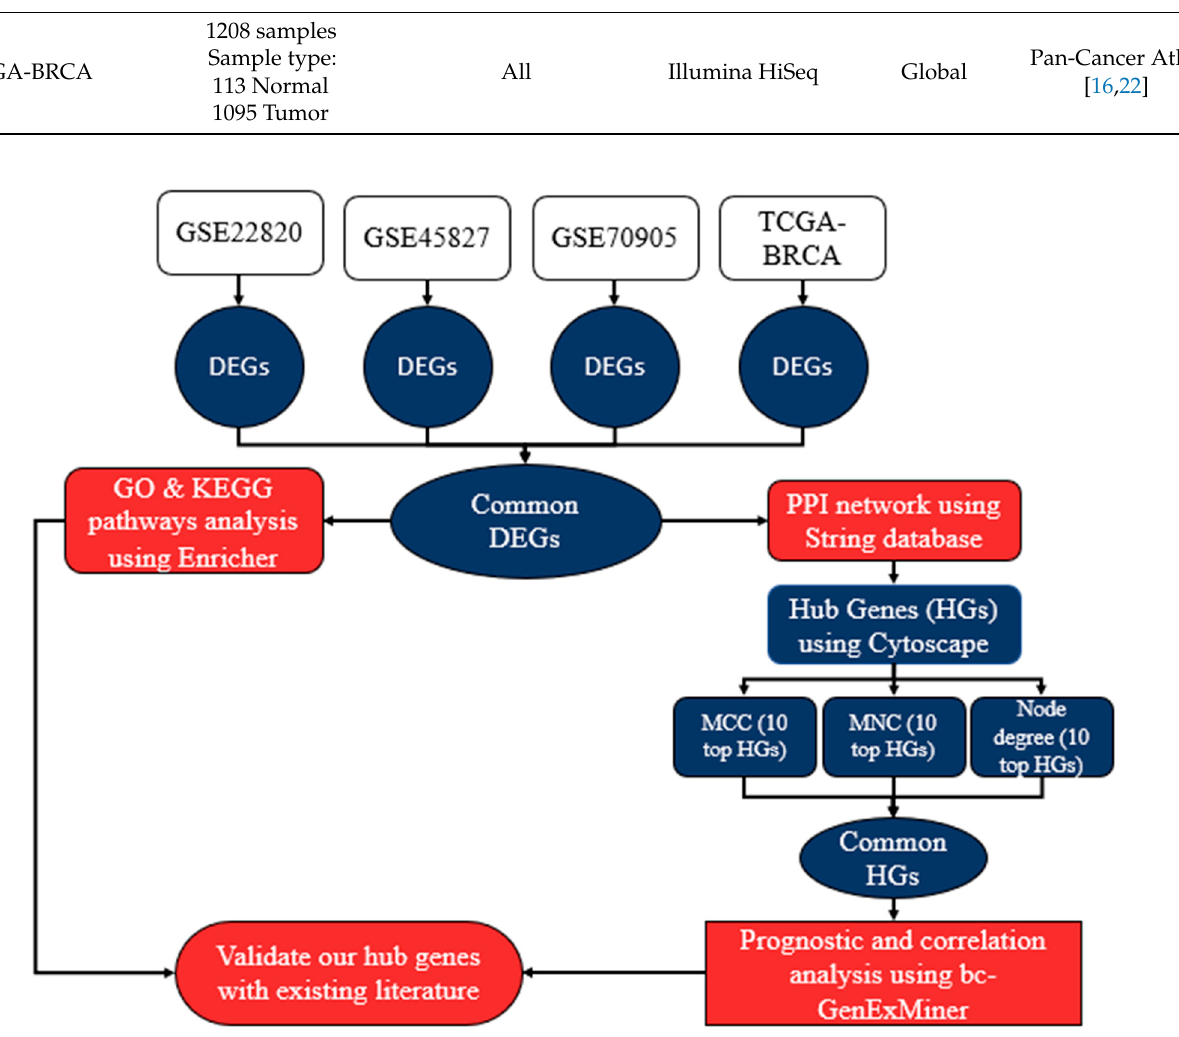
Figure 1. The overall research flowchart. Table 1. Metadata for the microarray and RNASeq datasets.